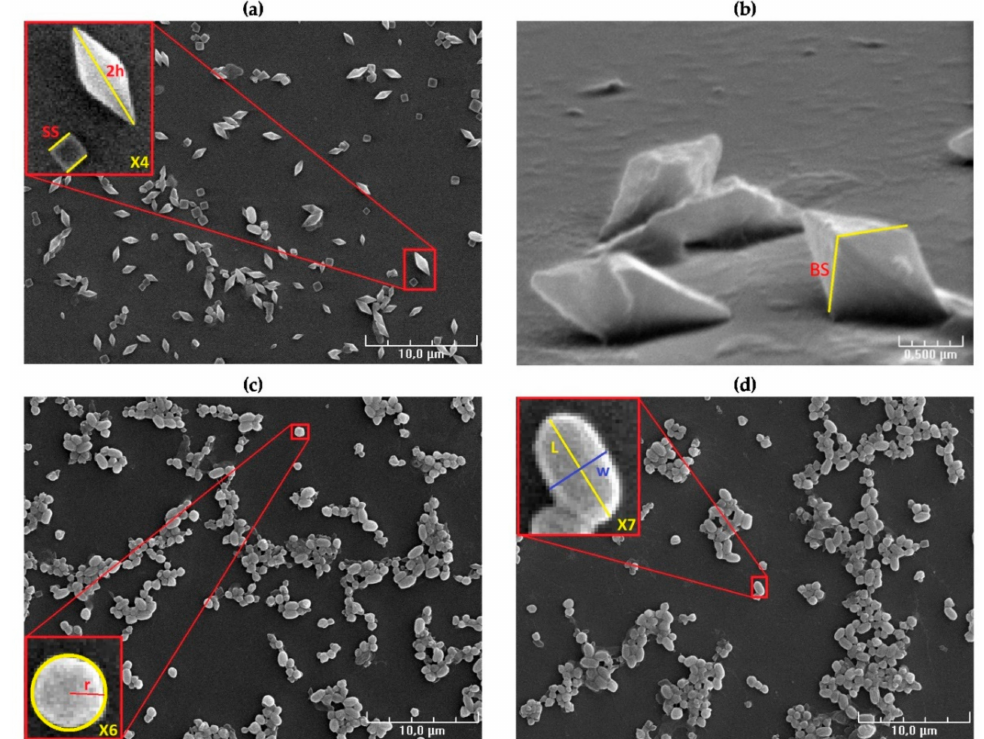
Figure 1. Examples of measurements of the different shapes of B. thuringiensis crystals and spores. ( a ) SEM image of the LIP MKA strain showing in yellow the measurement of the height of the bipyramid (2 h) and the side of the square (SS) of the cubic crystals. ( b ) SEM image of the LIP MKA strain indicating the side of the square (BS) forming the base of the bipyramid. ( c ) SEM image taken for a AR23 strain’s purified crystals showing the measurement of the perimeter of the sphere where we calculated the radius r of the latter. ( d ) SEM image taken for a AR23 strain showing the measurements of the length (L) in yellow and the width (W) in blue of the